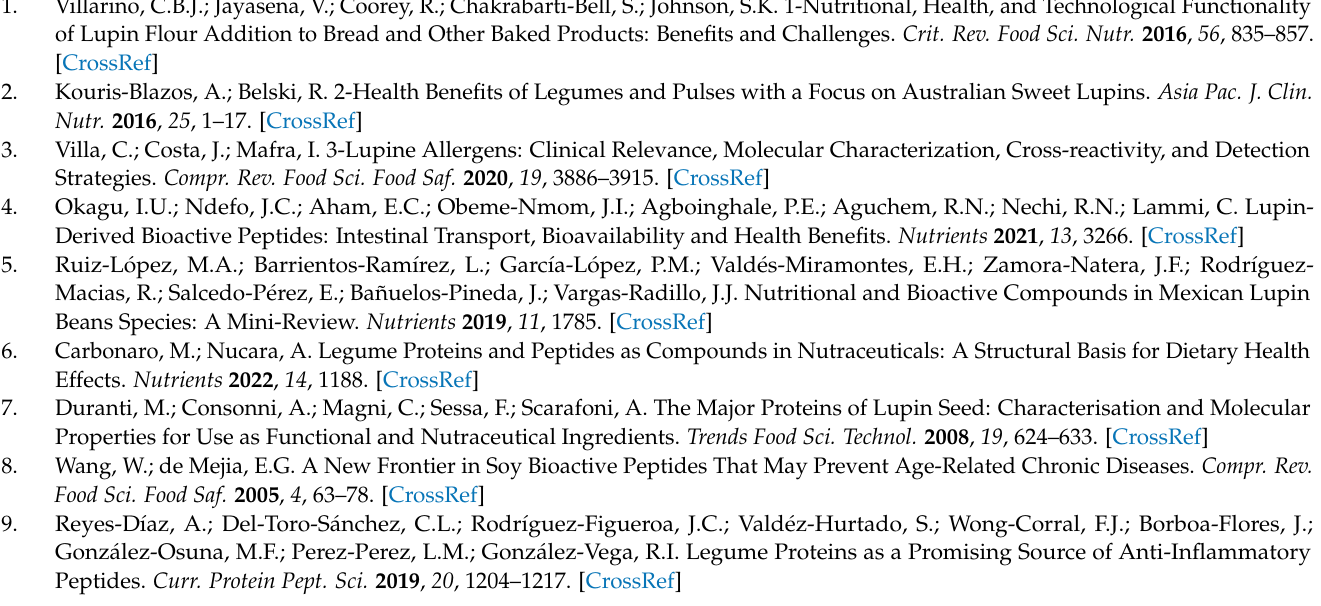
Figure S3: Vitality of Caco-2 cells after 4 h of treatment with intact γ -Conglutin ( γ -C) and digested with pepsin and pancreatin (DPP); Figure S4: Effects of the 4 h incubation of differentiated Caco-2 cells with 1 mg/mL ( γ -C) and pepsin and pancreatin digested sample (DPP) on SGLT1 and GLUT2 gene expression; Figure S5: Effect of γ -C-derived peptides at 2, 15 and 45 min of digestion on α -amilase (A) and α -glucosidase (B) enzymes